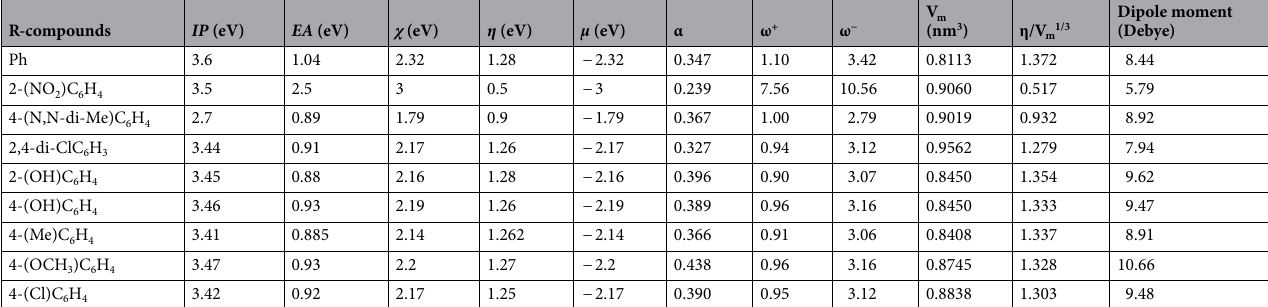
Table 3. Quantum descriptor of pyrazoloquinolines